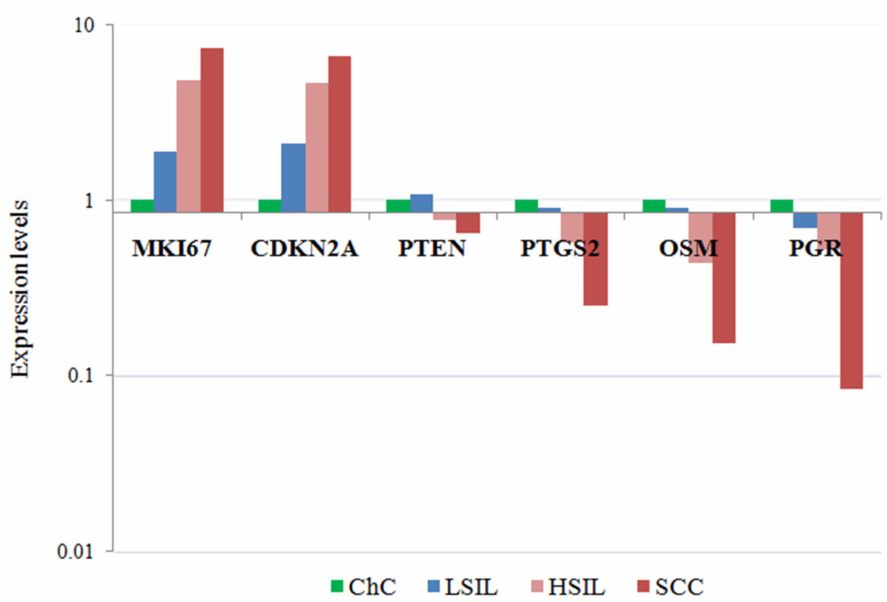
Figure 1. mRNA expression levels in cells of cervical smears with lesions of the cervical epithelium. The medians of the level of gene expression with statistically significant differences in the study groups are